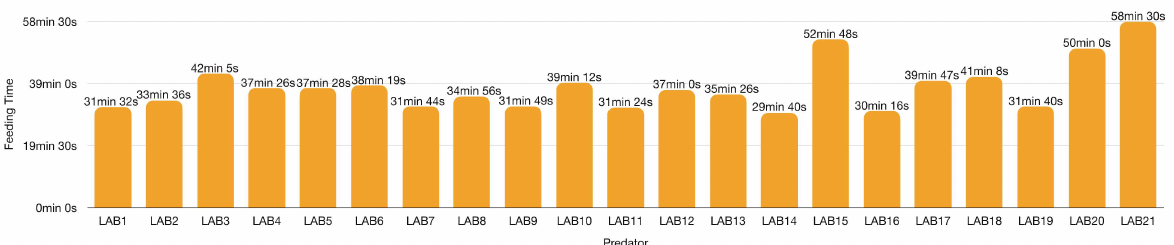
Figure 11. Z. renardii average feeding time. Each bar represents the average time that LABs took to feed on each prey.